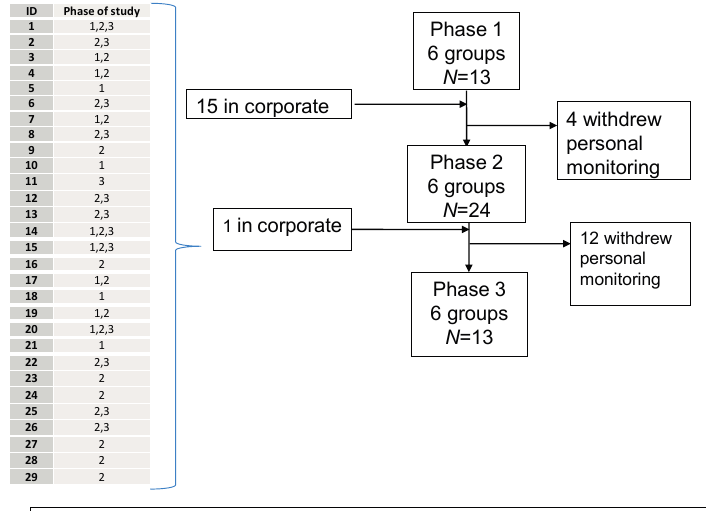
Figure 1. Personal exposure